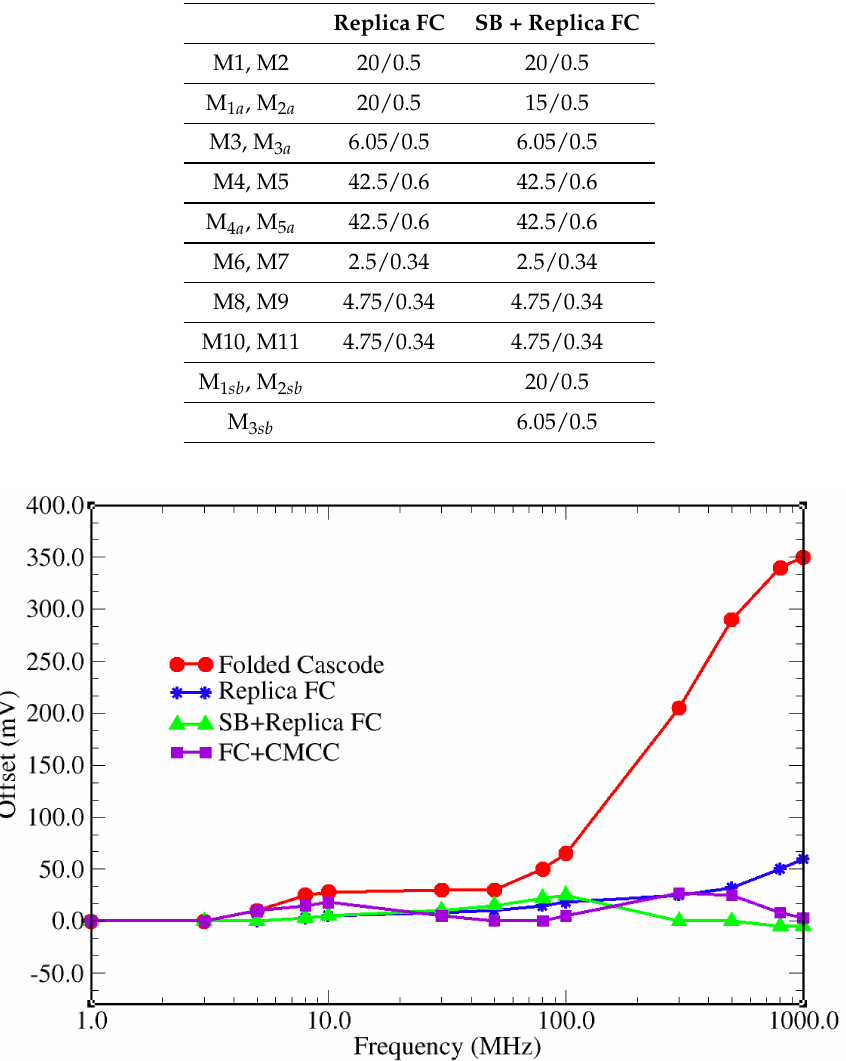
Table 4. Transistors’ aspect ratio (W/L) [ µ m] in the folded cascode architectures.